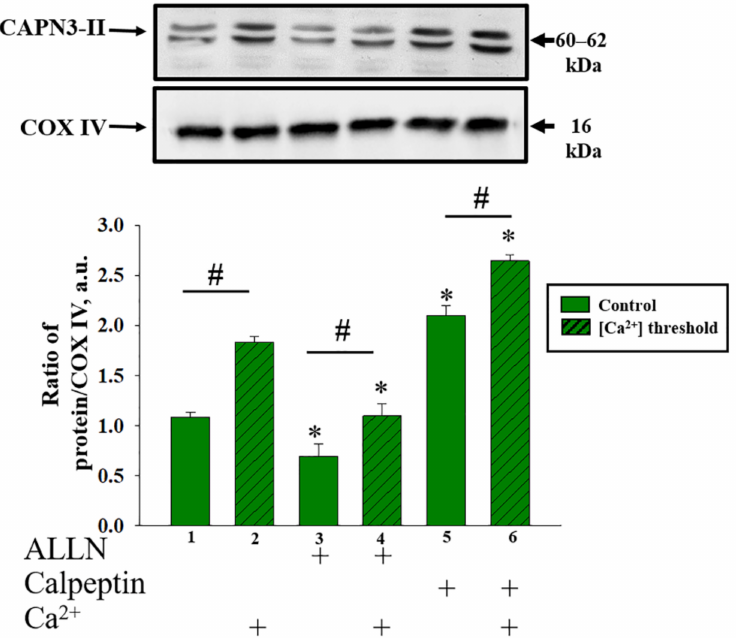
Figure 7. The effect of Calpain inhibitors, ALLN and Calpeptin on the level of CAPN3 domain II in RBM in control and mPTP conditions (threshold [Ca 2+ ]). The upper parts represent Western blots stained with the corresponding antibodies. Lower parts—quantitation of immunostaining using computer-assisted densitometry. The protein band intensity was quantified after normalization to COX IV. The values shown are the means ± SD from three independent experiments. * p ≤ 0.05 compared with the corresponding value of Calpain 3 domain II without additions of inhibitors, (columns 3, 5 vs. column 1 and columns 6 and 4 vs. column 2, respectively), # p ≤ 0.05 compared with the corresponding control without [Ca 2+ ] threshold (Columns 2 vs. 1, 4 vs. 3 and 6 vs. 5,